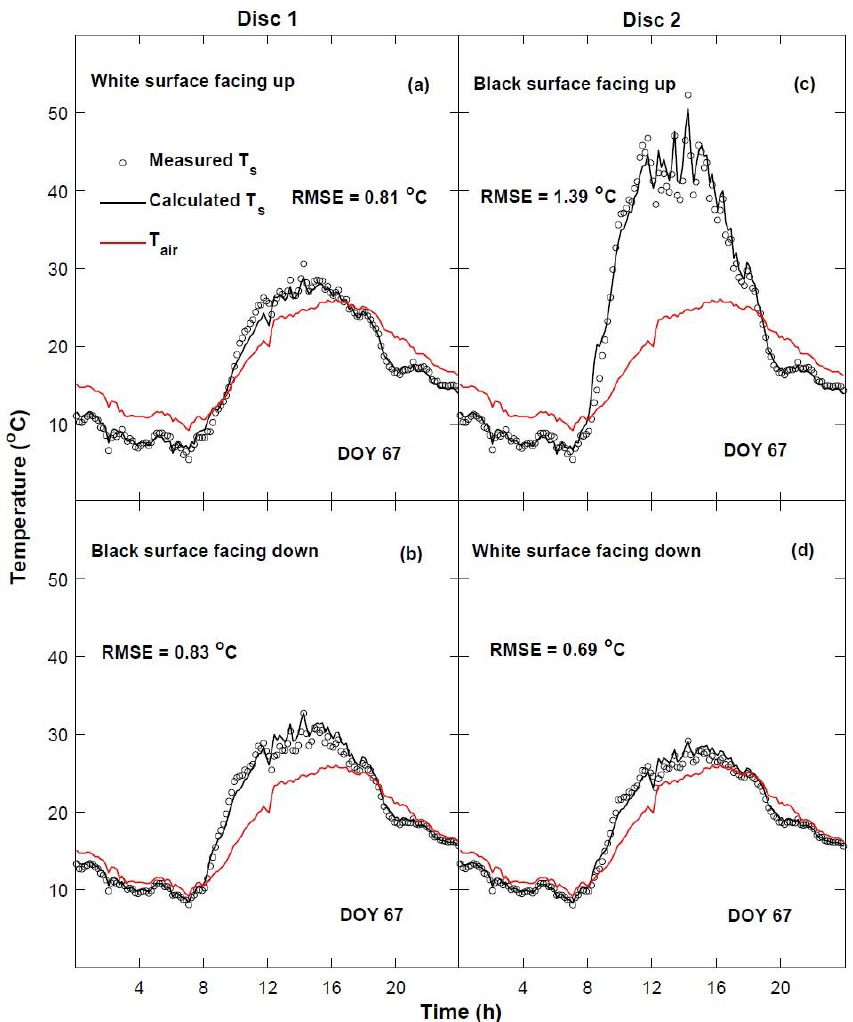
Figure 6. Calculated and measured surface temperature of the discs on day of year (DOY) 67. Disc 1 had its upper surface painted white ( a ) and its lower surface painted black ( b ), whereas Disc 2 was the opposite ( c , d ). Deviation between measured and calculated values for each surface is given by the root mean square error (RMSE).